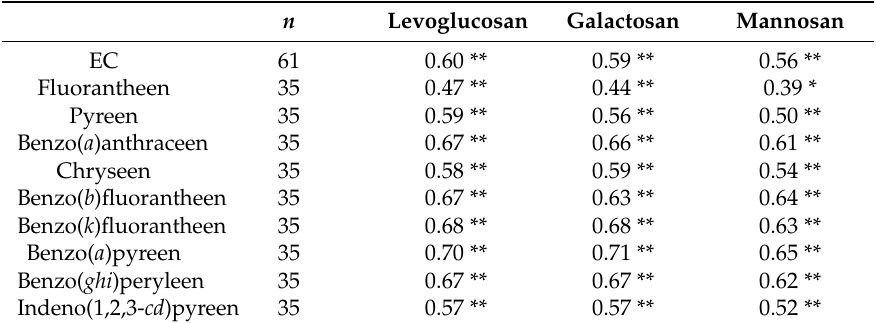
Table 2. Spearman rank correlation coefficients ( r s ) between MA tracers and OC, and PAHs. Significant correlations are indicated (* p < 0.05; ** p < 0.01). n